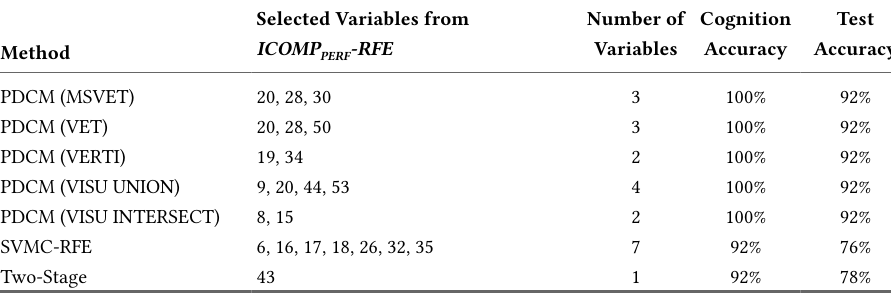
Number of Variables